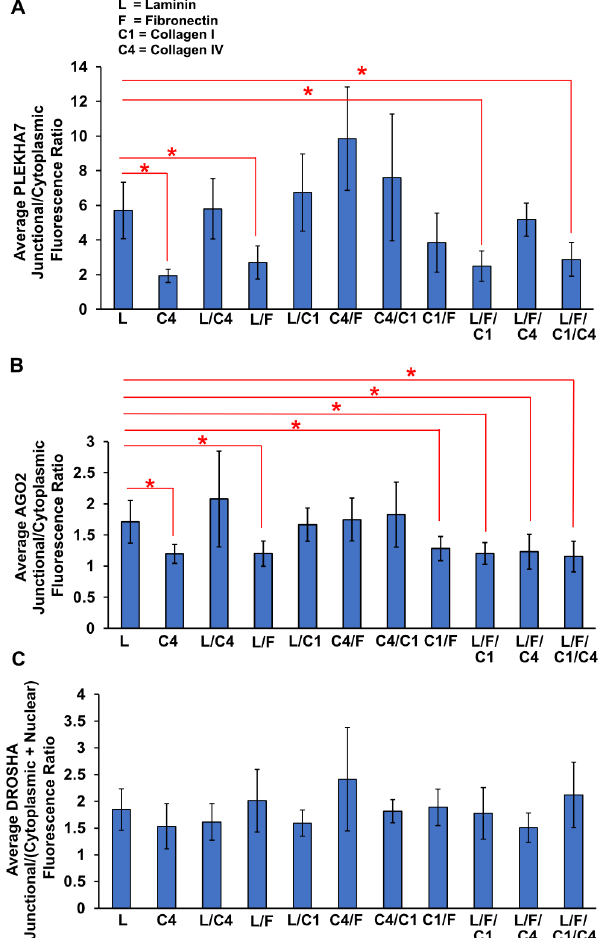
Figure 8. Average junctional/cytoplasmic fluorescence intensity ratios of PLEKHA7 ( A ) and AGO2 ( B ) in Caco2 colon epithelial cells plated on different combinations of ECM substrates, compared to that of laminin. ( C ) Average junctional/(nuclear + cytoplasmic) fluorescence intensity ratio of DROSHA in Caco2 colon epithelial cells plated on different combinations of ECM proteins. Data were analyzed using one-way ANOVA with the Shapiro – Wilk test for the normality test and Bonferroni correction for pair-wise comparison, where p < 0.05 and 9 ≤ n ≤ 15 (see also Methods, Section 2.5). Statistical significance of p < 0.05 is indicated by asterisks (*).